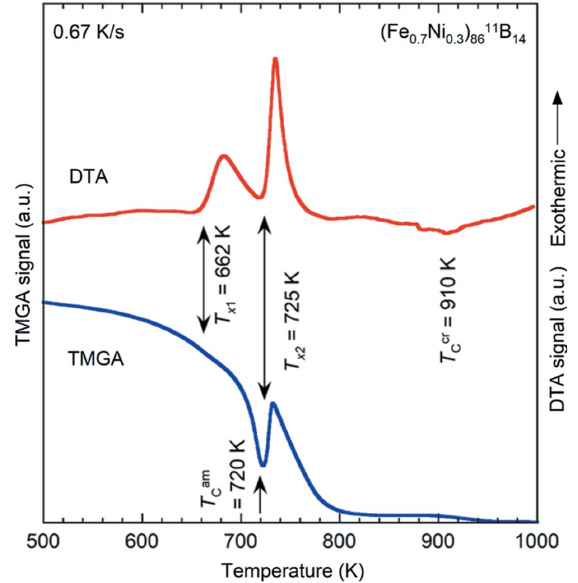
Figure 3 Results of DTA (red solid line) and TMGA (blue solid line) for amorphous (Fe 0.7 Ni 0.3 ) 86 B 14 alloy. The arrows mark the crystallization and Curie temperatures.